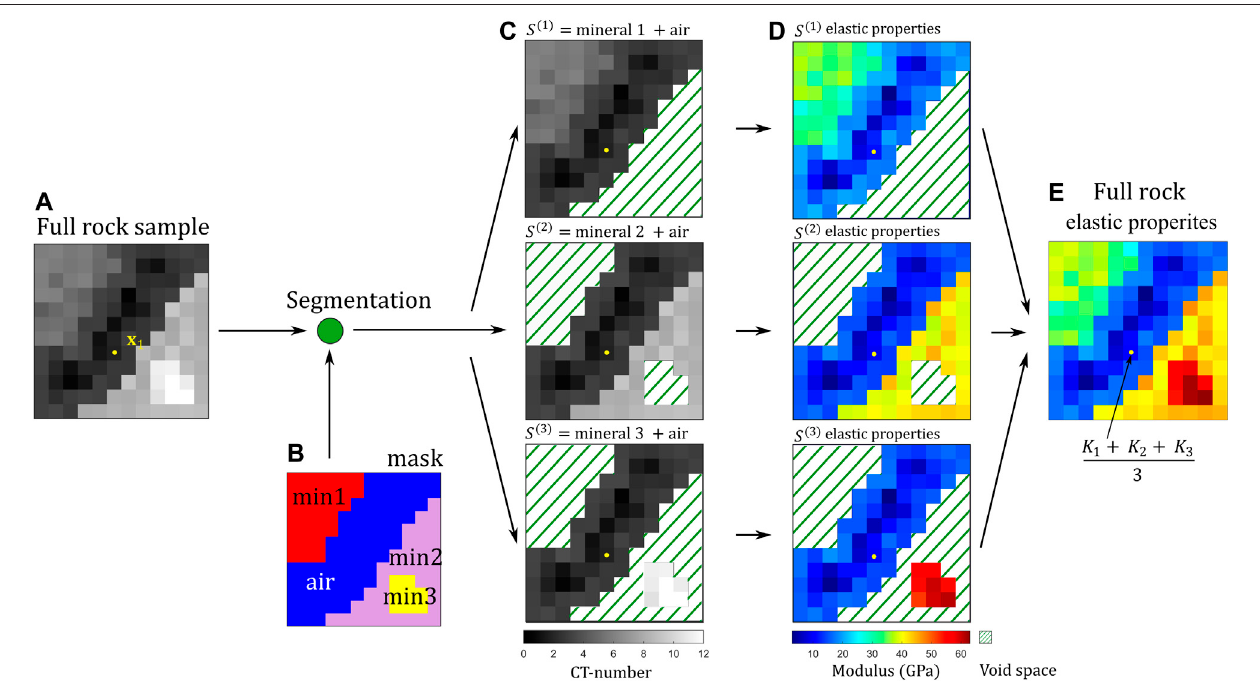
FIGURE6| Thediagramofthemodi fi ed-SLOT.Here,weshowanexampleofatwo-dimensionalsectionofarocksampleconsistingofthreemineralphases (A) .In the CT-volume, the domain is discretized on a uniform grid depending on the resolution of the scan. The fi rst step of the modi fi ed-SLOT is to partition the domain into small subdomains ( S ( 1 ) , S ( 2 ) , and S ( 3 ) ) using the segmentation mask (B) . Each subdomain consists of two phases: a mineral phase and the air phase (C) . Next, since thesubdomainsaremonomineralic,weapplytheSLOTtoeachsubdomain,transformingtheCT-volumesintheelasticpropertiesvolumes (D) .Finally,wecombine each subdomain, getting back the full volume elastic properties volume. In the fi gure, x 1 is located in the air phase. The elastic properties at x 1 in the full volume is the average of the elastic properties from each subdomain (i.e., ( K 1 + K 2 + K 3 ) / 3) (E) .